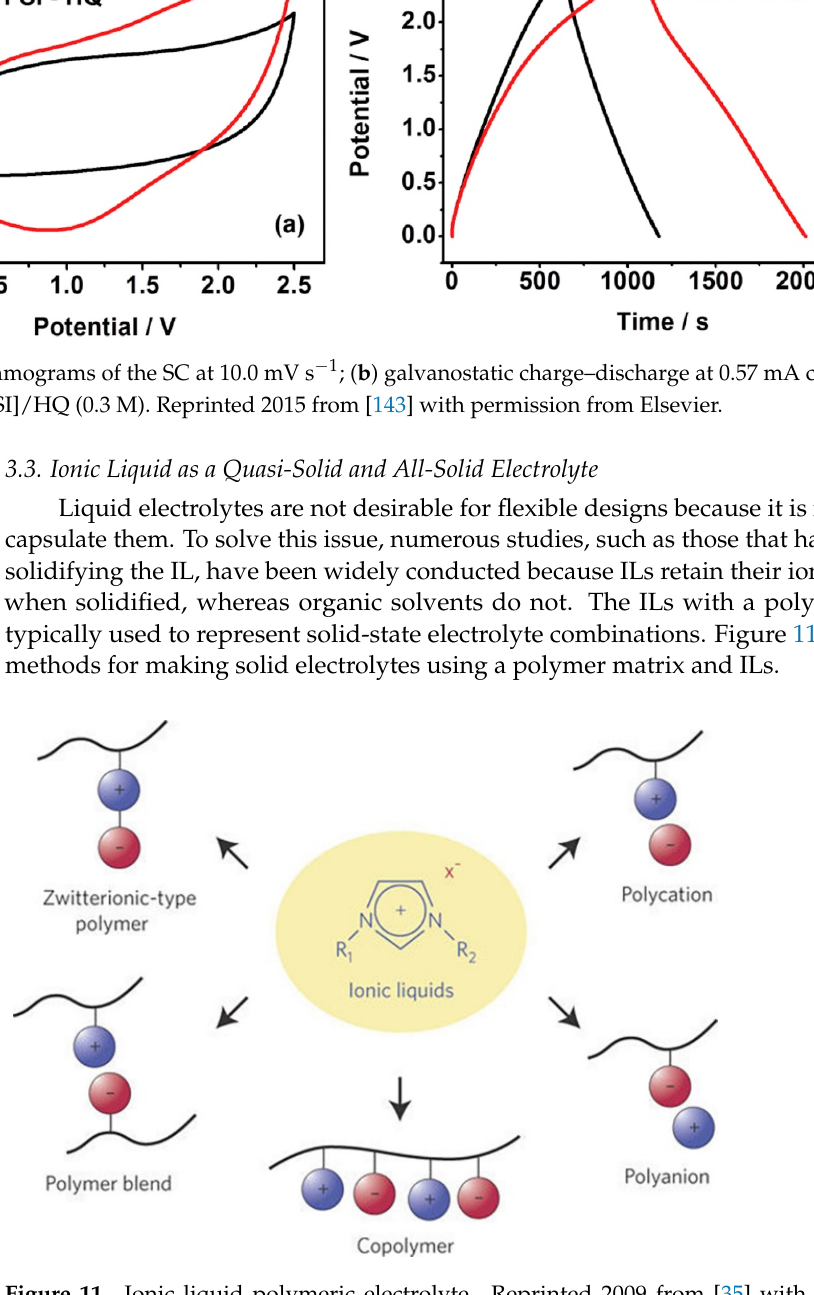
Figure 11. Ionic liquid polymeric electrolyte. Reprinted 2009 from [35] with permission from Springer Nature.